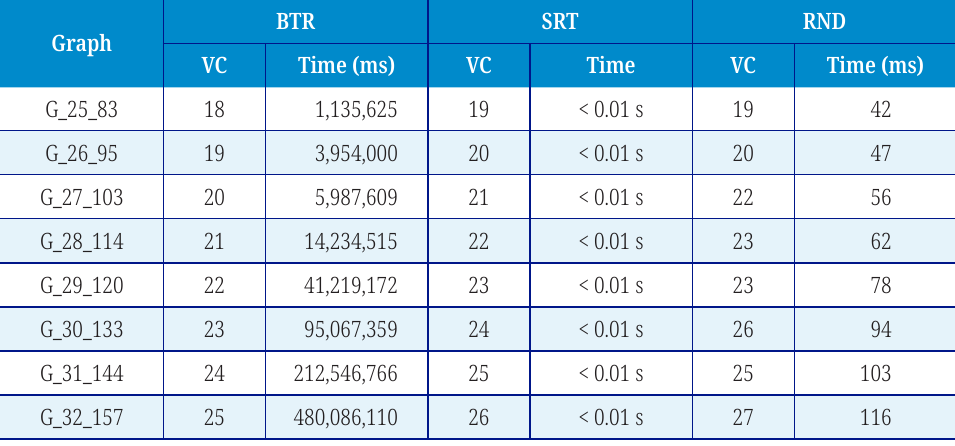
Table 2. Summary results after running the three algorithms (BTR, SRT and RND)